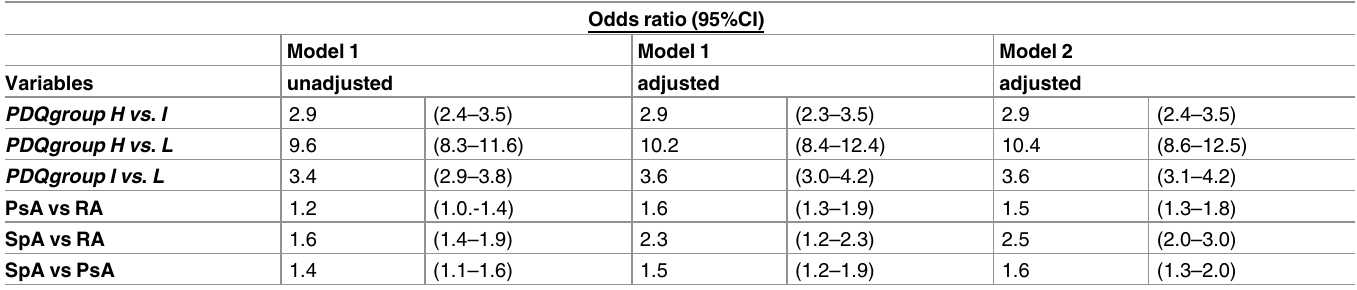
Table 4. Logistic regression analysis for modeling high pain status ( (cid:21) median VAS pain of 39